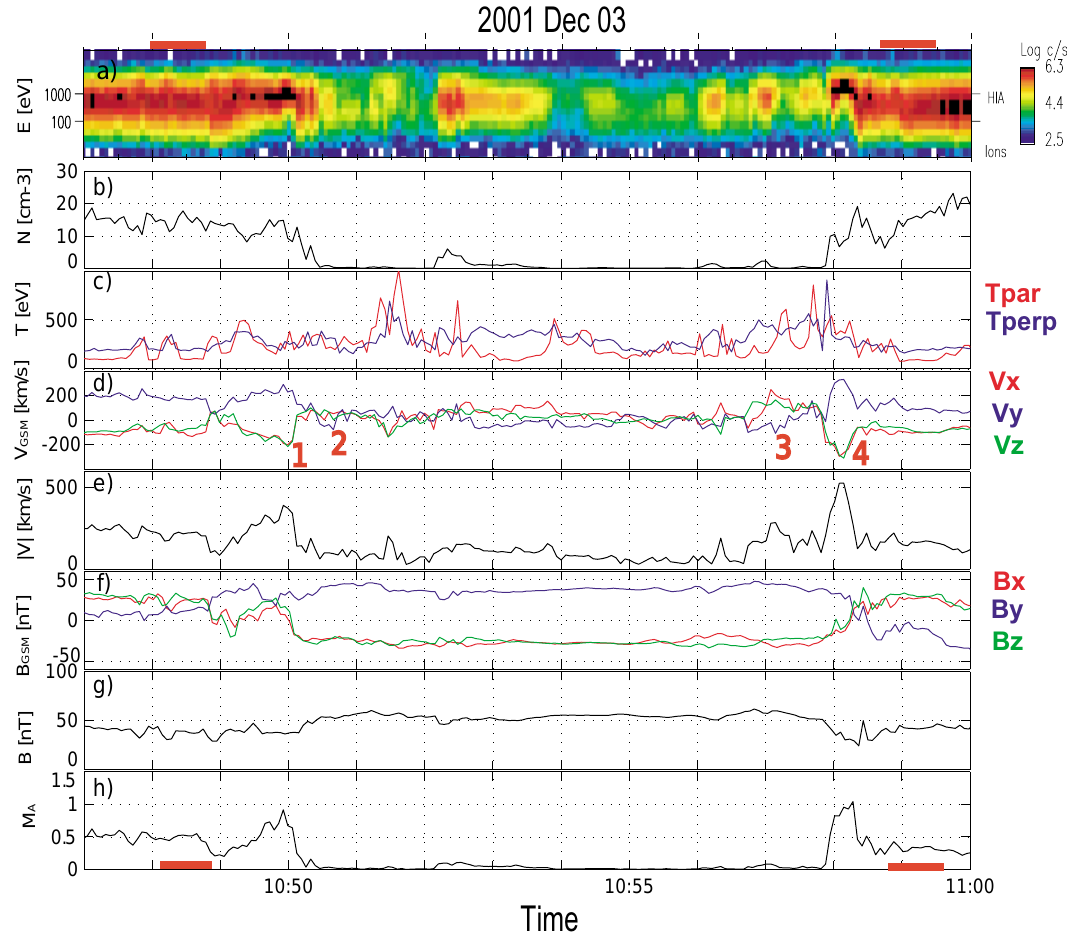
Fig. 3. Ion and magnetic field data for SC/3 in the time interval 10:47–11:00 UT. Panels show from top to bottom: (a) ion energy spectrogram, (b) ion number density, (c) parallel and perpendicular ion temperatures, (d) ion velocity components in GSM, (e) ion total velocity, (f) magnetic field components in GSM, (g) total magnetic field and (h) Alfv´enic Mach number. Reconnection flows are indicated by red labels 1–4 while magnetosheath reference levels are shown by horizontal red